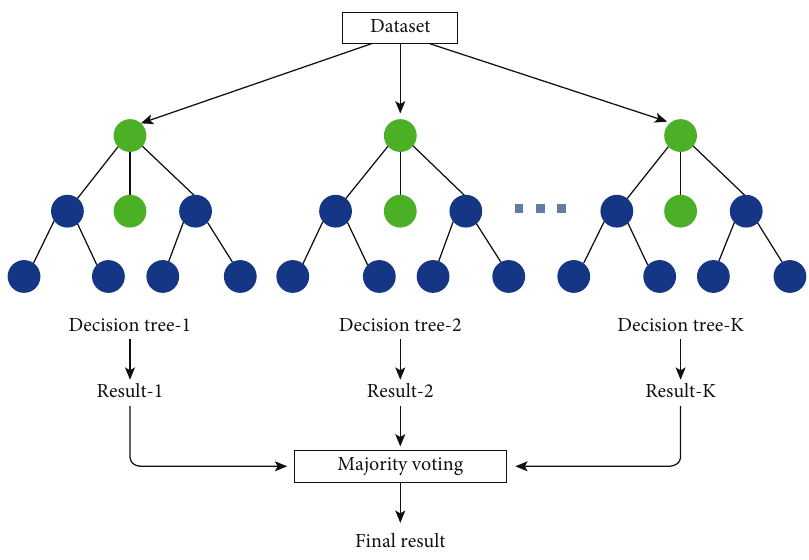
Figure 6: Random forest.